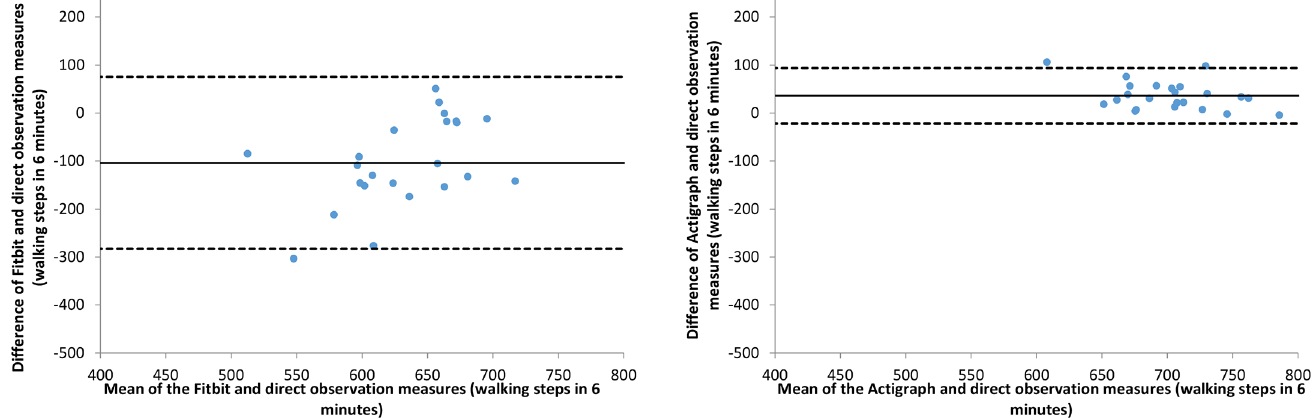
Fig 1. Bland-Altman plots of walking steps for the Fitbit and Actigraph compared to direct observation.